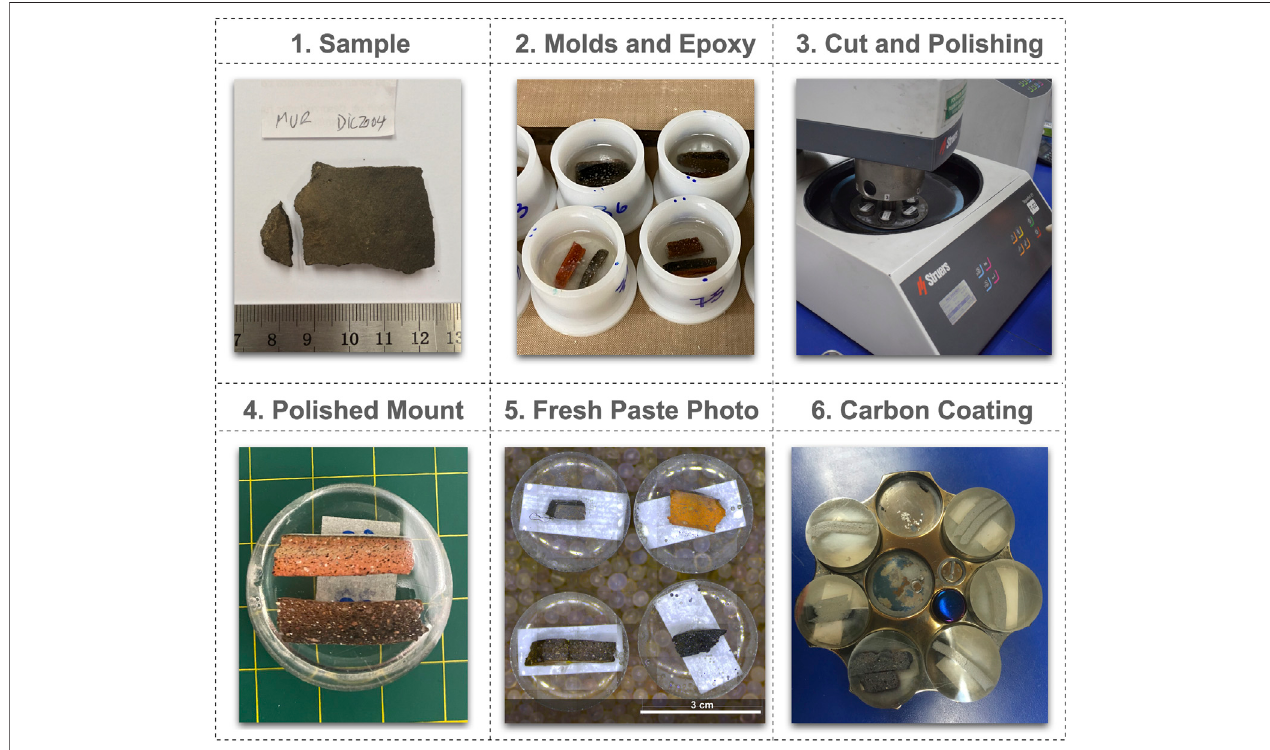
FIGURE 3 | Visual scheme of the employed sample preparation methodology. Ceramic fragments (up to 25 mm in size) were mounted in low-volatile epoxy and placed in 30 mm circular mounts. Each sample mount was polished fl at, and then carbon coated prior SEM analysis.